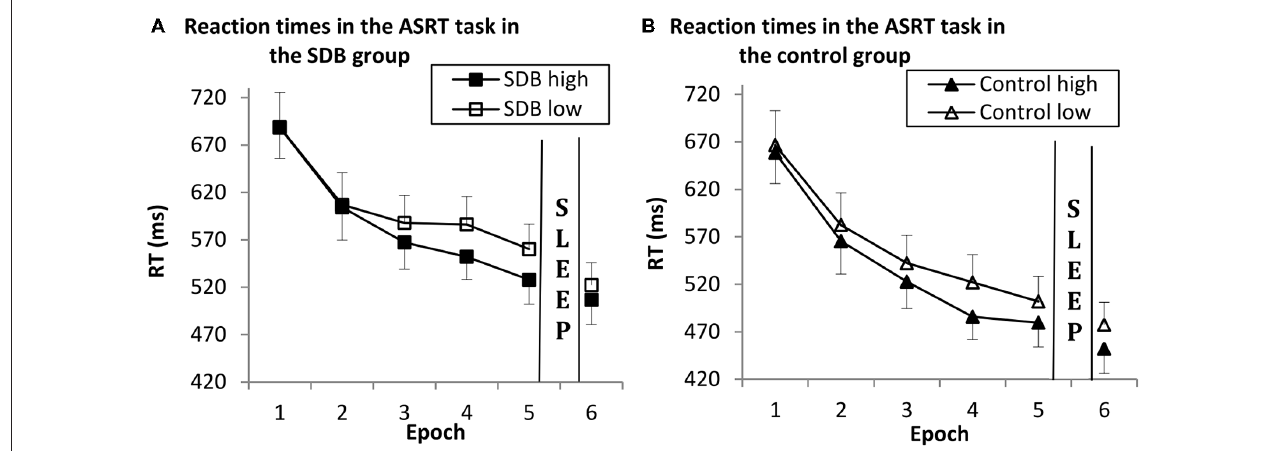
FIGURE 3 | Results of sequence-specific and general skill learning in the SDB (A) and control (B) group in Session 1 (Epoch 1–5) and Session 2 (Epoch 6) on reaction time measures. Both groups showed significant sequence-specific and general skill learning. There were no differences in learning and in offline changes between the groups; the pattern of learning was similar in the SDB and control groups. Error bars indicate SEM.